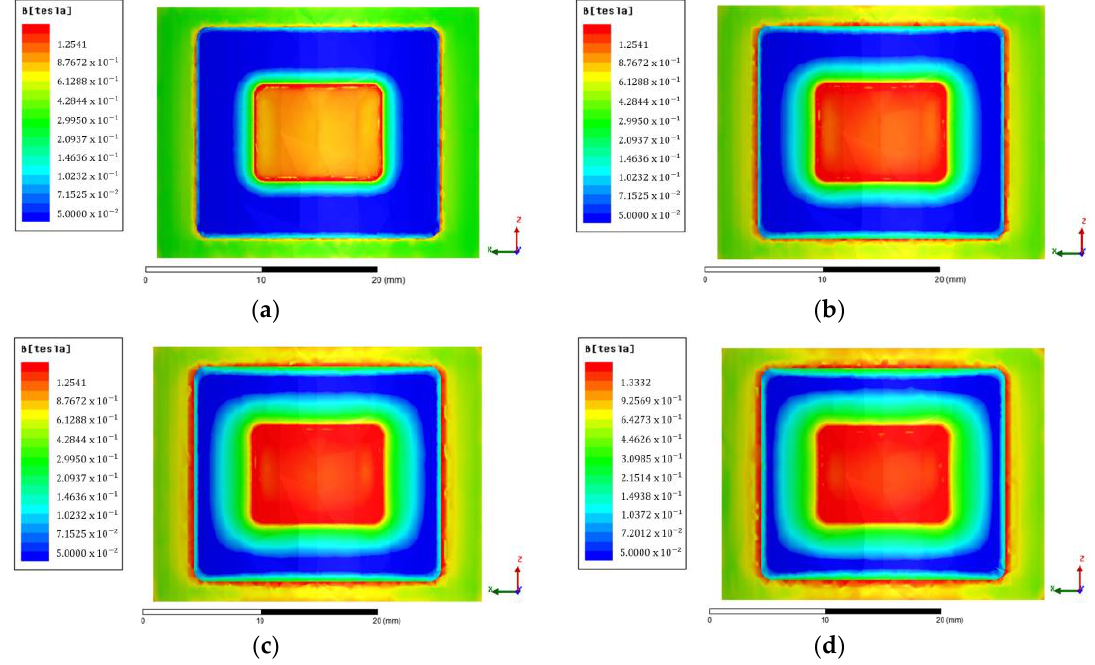
Figure 11. Contour of magnetic flux density at 0.5 mm fluid gap with variations of: ( a ) 150 tA; ( b ) 300 tA; ( c ) 450 tA; ( d ) 600 tA.